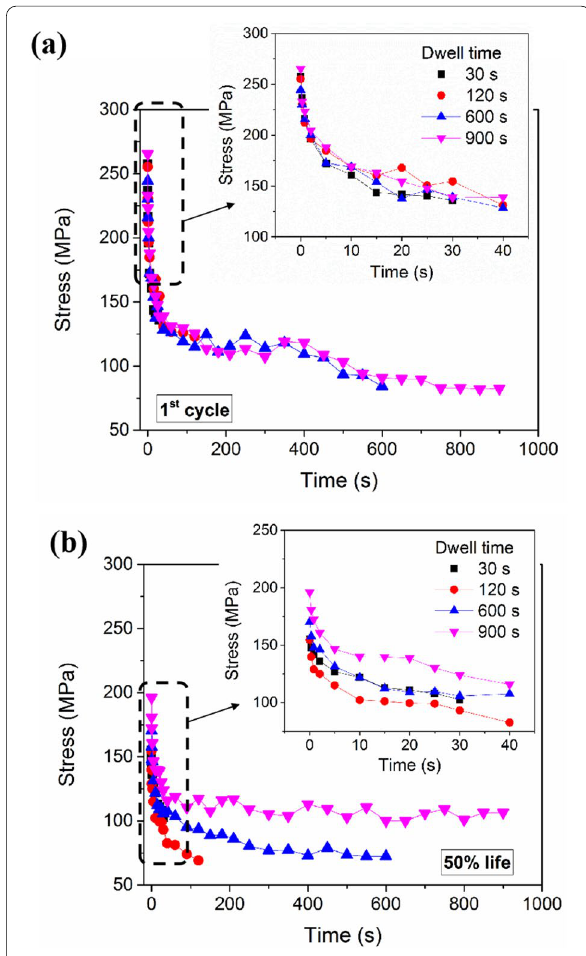
Figure 7 The stress relaxation during the different dwell periods of 1st cycle and 50% life for the typical CF